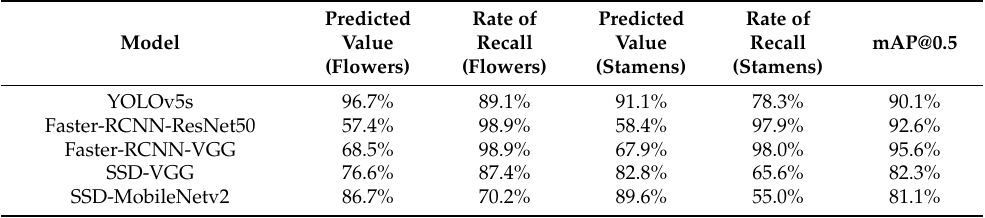
Table 3. Test results of the five models regarding flower